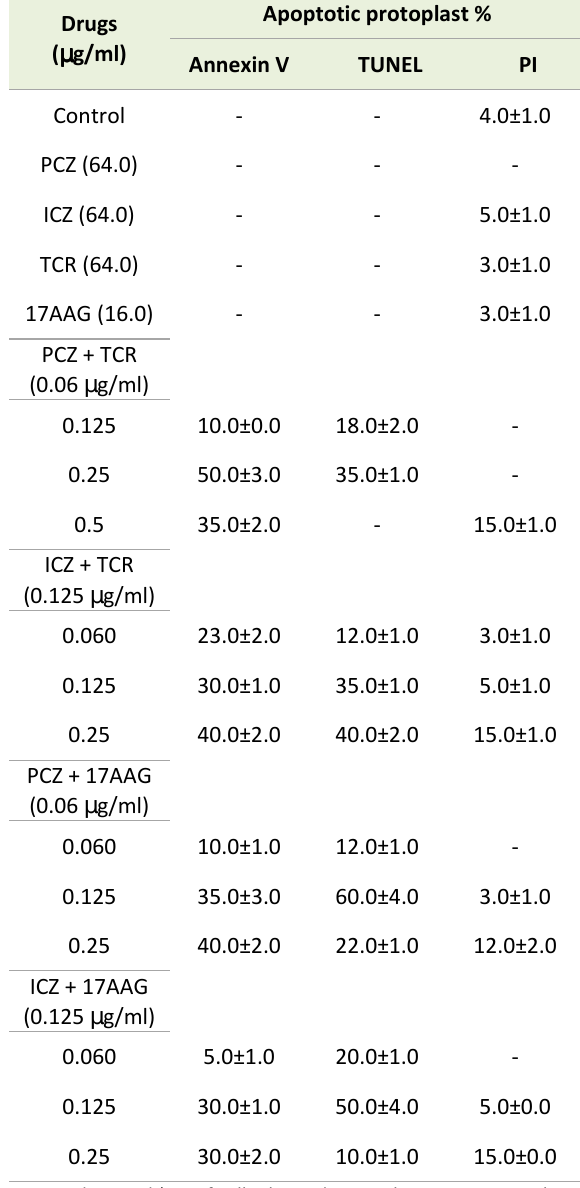
TABLE 2. Percentage of S. prolificans (isolate 1) cells stained with annexin V, TUNEL and PI for detection of phosphatidylseriene ex- posure, DNA fragmentation and cell membrane integrity respec-